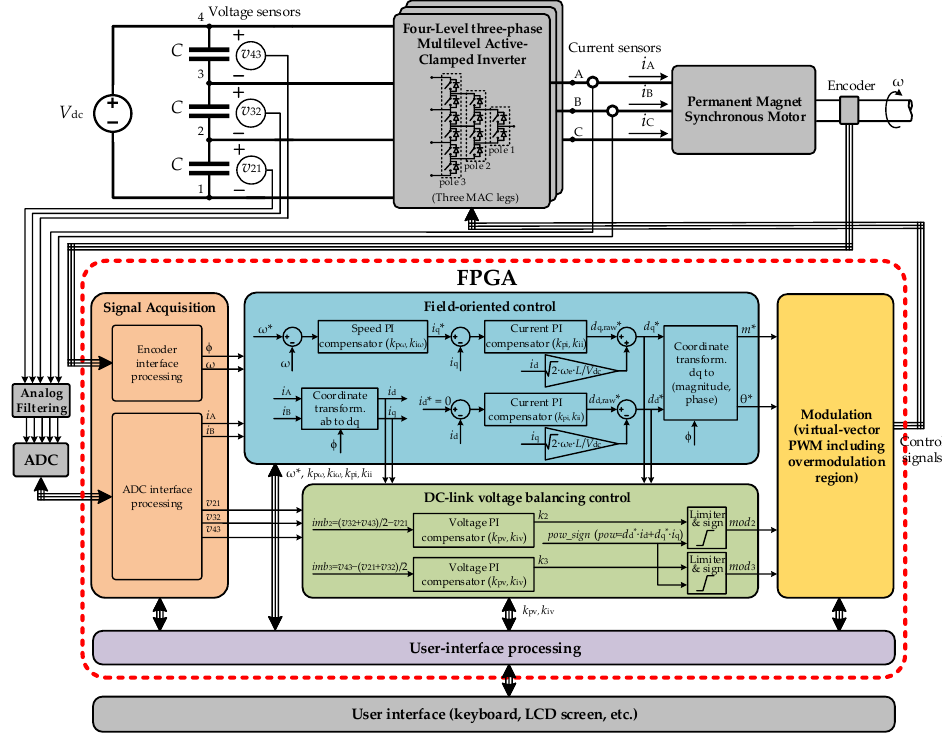
Figure 2. Global system overview.